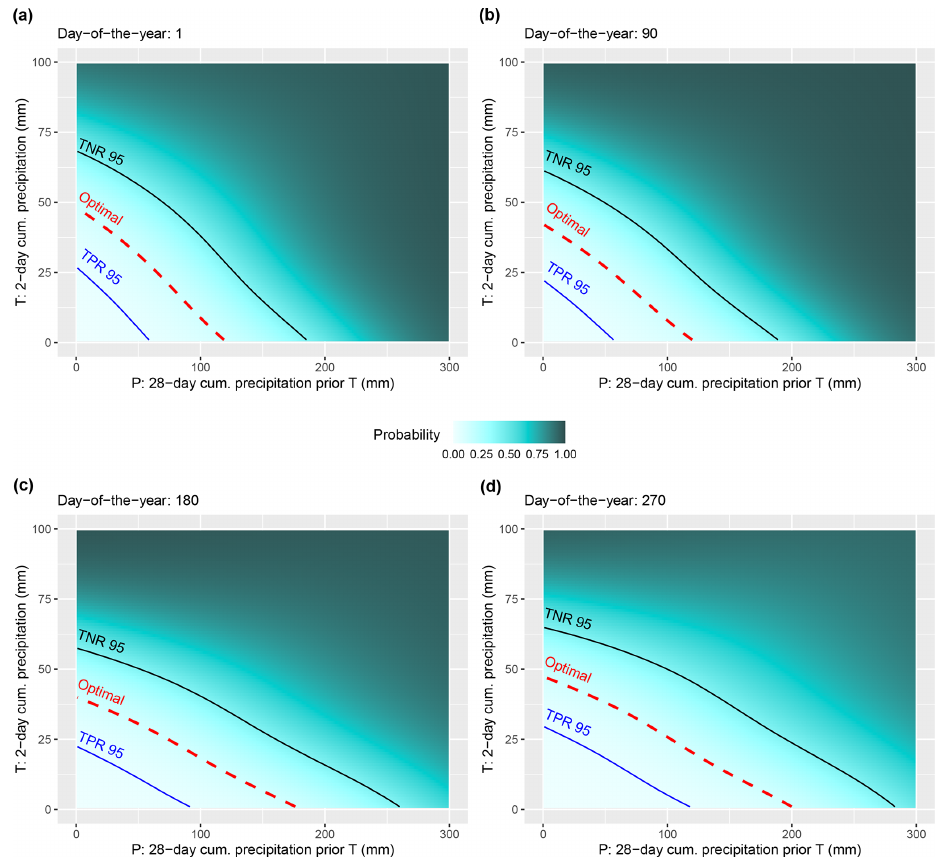
Figure 9. T – P plot showing the predicted probability for increasing precipitation amounts ( T , P ) and associated thresholds for a selected DOY: day 1 (a) , day 90 (b) , day 180 (c) , and day 270 (d) . The animation in the Supplement (Animation.gif) visualizes the continuous changes from day 1 to